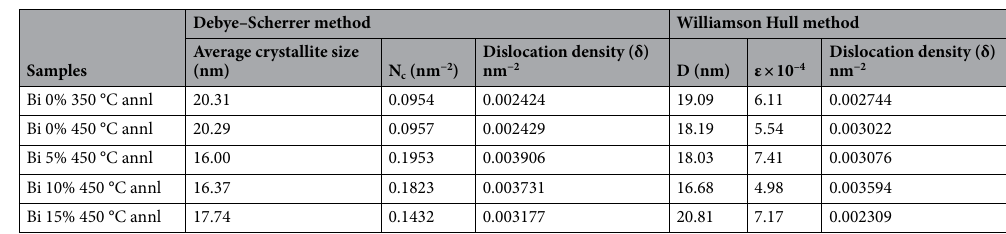
Table 1. Calculated lattice parameters of annealed Bi x In 35-x Se 65 thin films.